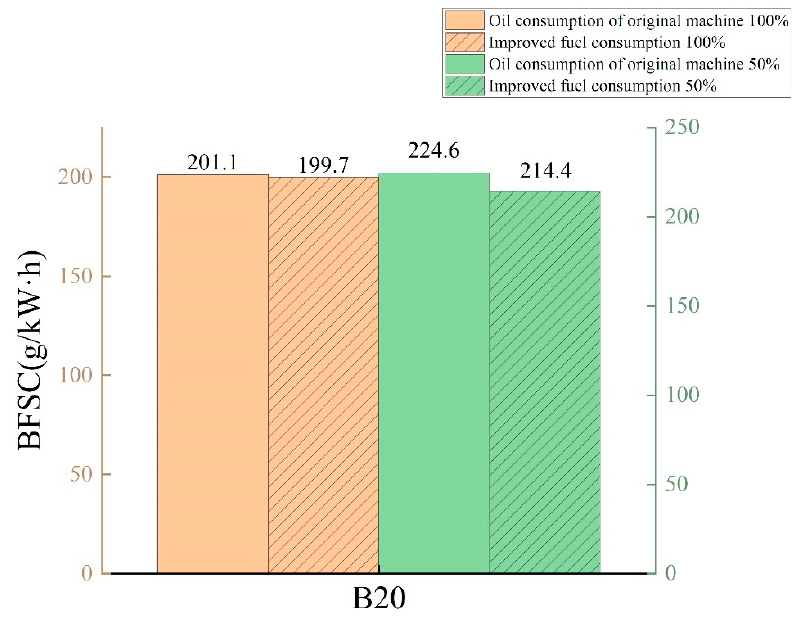
Figure 14. Comparison of improved fuel consumption with original value at 100% and 50% load.